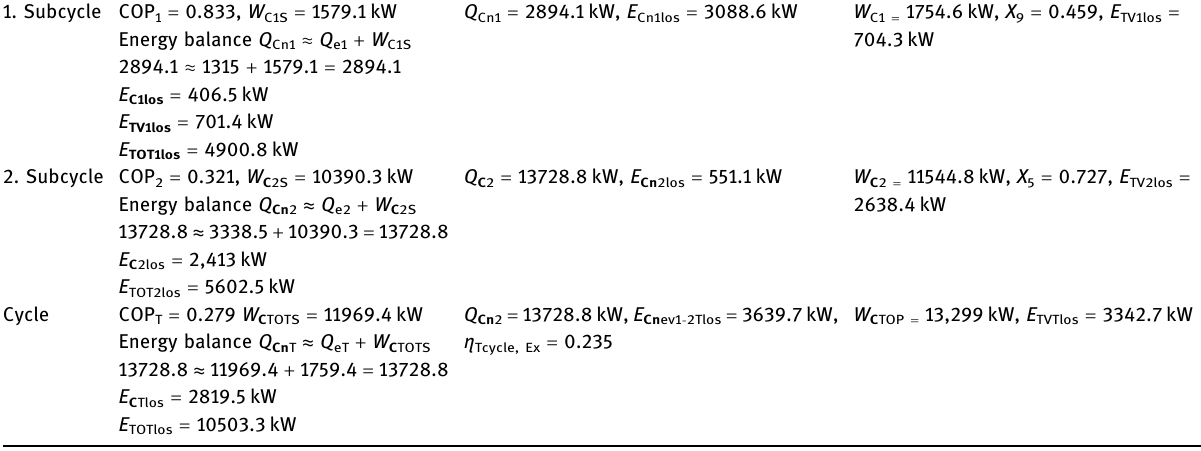
Table 7: Energy balance, COP exergy e ffi ciency, and exergy losses for natural gas entering at 20°C and 400 kPa ( P 7 = 2,400 kPa )